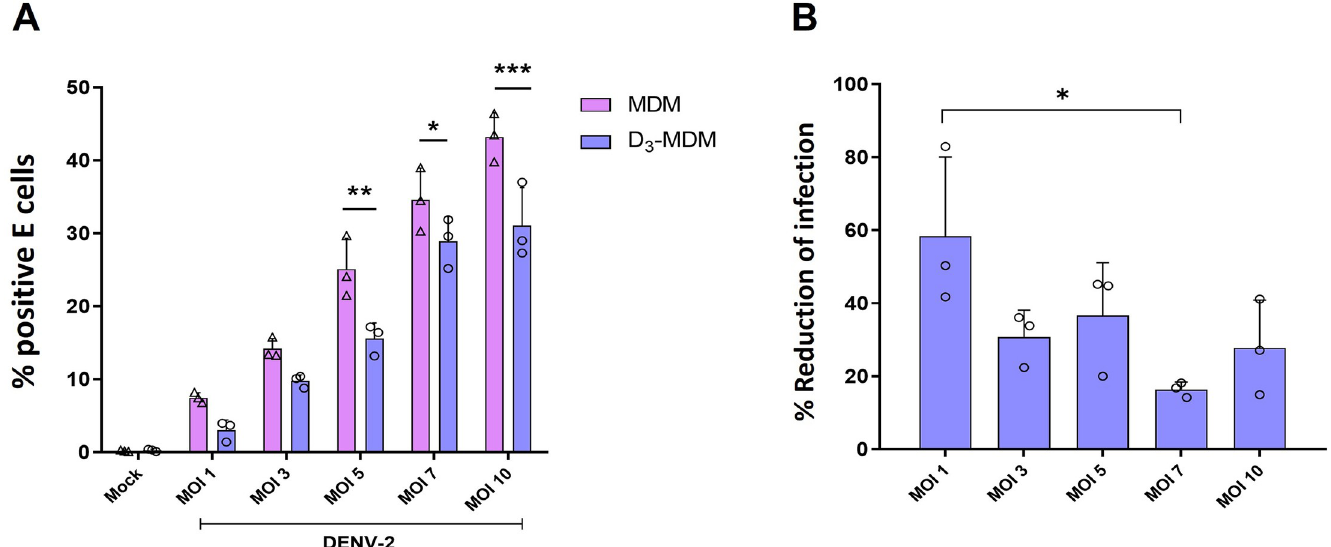
Fig 2. Reduction of E-positive cells in D 3 -MDMs infected with different MOI of DENV-2. The MDMs were differentiated in the presence of VitD3 (0.1 nM) for 6 days (D 3 -MDMs) and then infected with DENV-2 with different MOI for 24 h. Infection was evaluated through flow cytometry and expressed as % E-positive cells. Three different donors were analyzed. Differences were obtained with a two-way ANOVA with a Bonferroni posthoc test and a 95% confidence interval ( ��� p < 0.001, �� p < 0.01, � p <